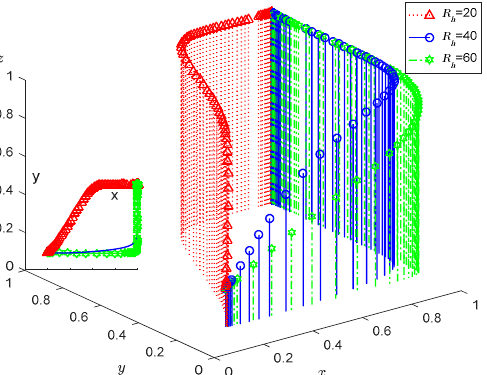
Figure 7. Simulation of evolutionary strategies of producers under different traceability benefits.